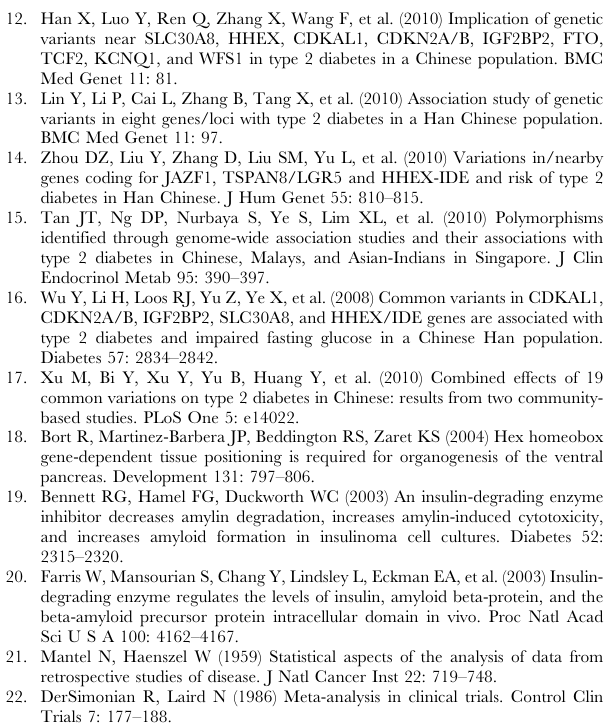
Table 5. Combined effects of rs7923837 and rs1111875 on type 2 diabetes Figure S1 The 290-kb linkage disequilibrium analysis on 10q23.33 and tagging single-nucleotide polymor- phisms (chr10:94199856–94489557). The IDE-KIF11-HHEX locus at 10q23.33 (chr10:94199856–94489557) splits into 5 linkage disequilibrium (LD) blocks in Asians (Chinese & Japanese). 19 single-nucleotide polymorphisms (SNPs) (seen at the black arrows) were selected for genotyping in the discovery stage, including 13 haplotype-tagging SNPs (htSNP), chosed with criteria of minor allele frequency (MAF) $ 0.10, Hardy-Weinberg equilibrium P $ 0.05, and call rate $ 95%) on the basis of pairwise LD r 2 threshold of 0.8, 3 potentially functional SNPs and 3 SNPs previously reported by GWAS of type 2 diabetes.